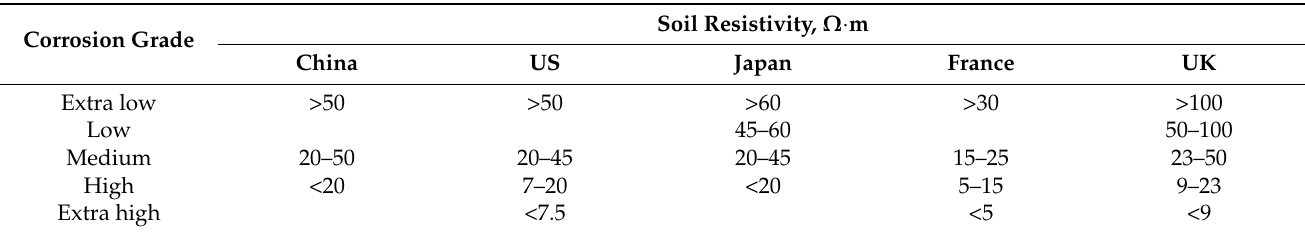
Table 1. Standards for evaluating soil corrosion degree based on soil resistivity in different